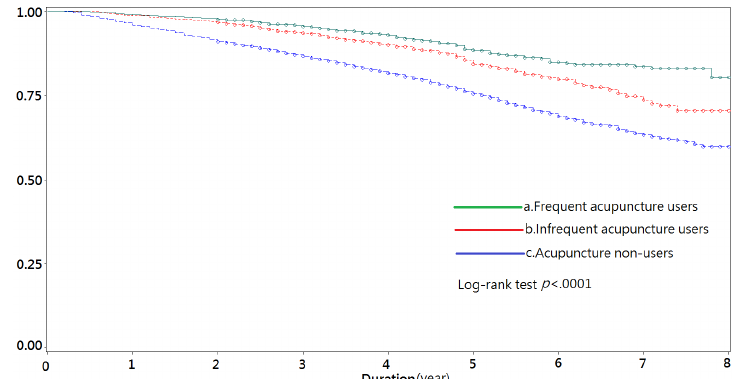
Figure 2. Kaplan–Meier Survival Curves of depression for comparing frequent acupuncture users, infrequent acupuncture users and non-users. a. Frequent acupuncture users: Subjects received six or more acupuncture treatments between 2000 and 2007 after stroke diagnosis; b. Infrequent